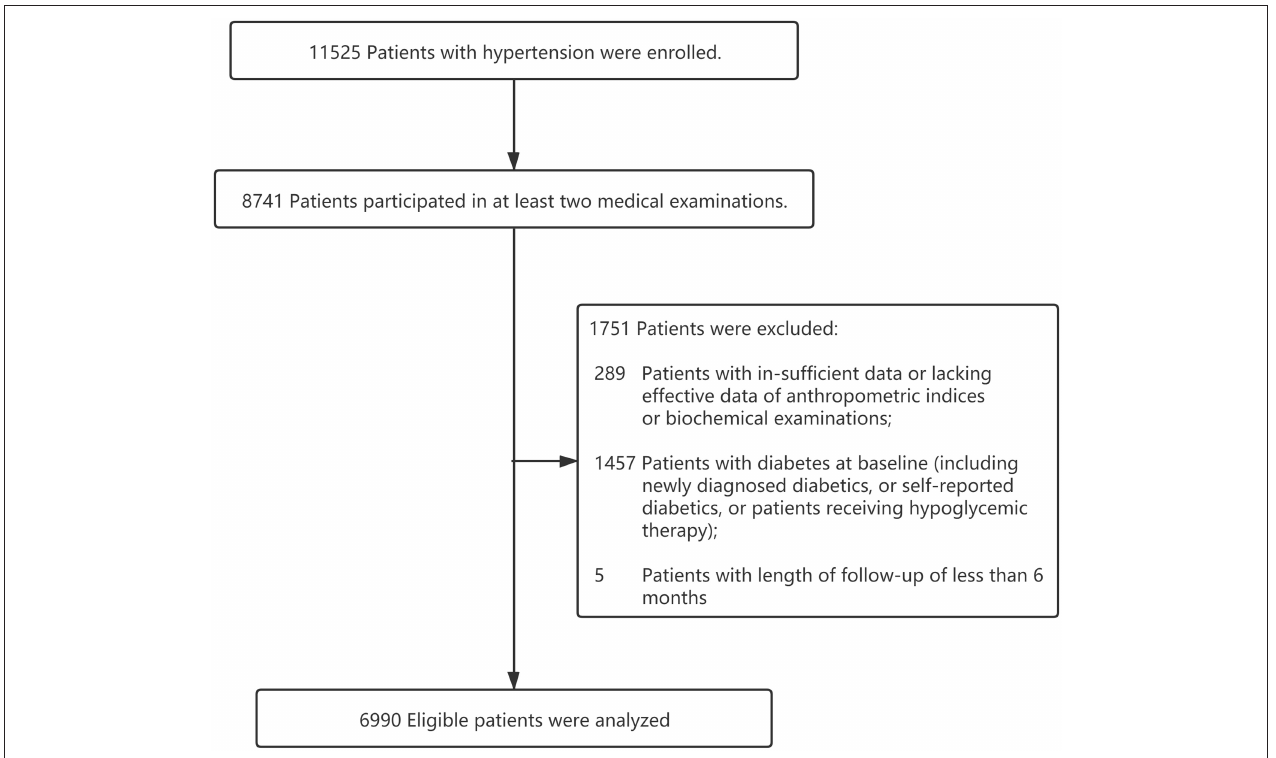
FIGURE 1 | Flow chart of the study